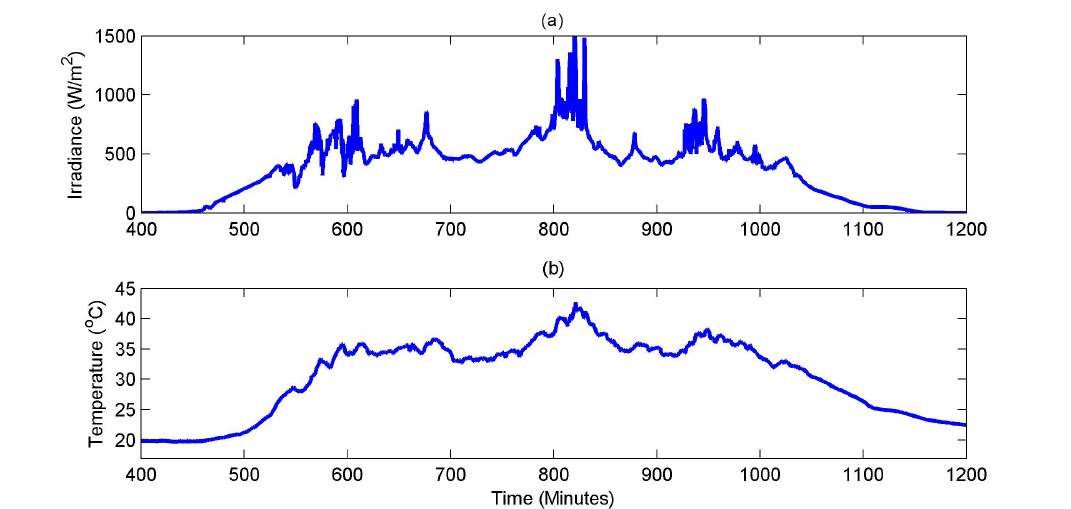
Figure 4. Atmospheric conditions: ( a ) solar irradiance; ( b ) ambient